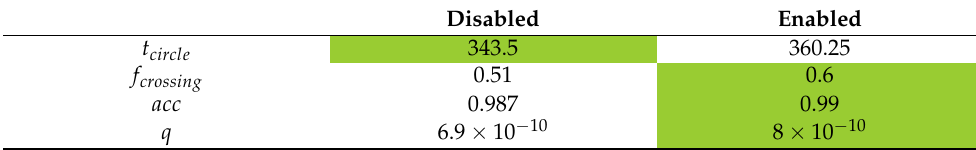
Figure 12. Successive D P positions during cloud boundary tracking calculated for two variants: m ( a ) correction procedure disabled, ( b ) correction procedure enabled; simulation scenario Cloud 5 . The colors of the points correspond to different values of (cid:101) χ . Table 8. Values of performance metrics obtained for variant IV, parameters from Table 1, disabled and enabled correction